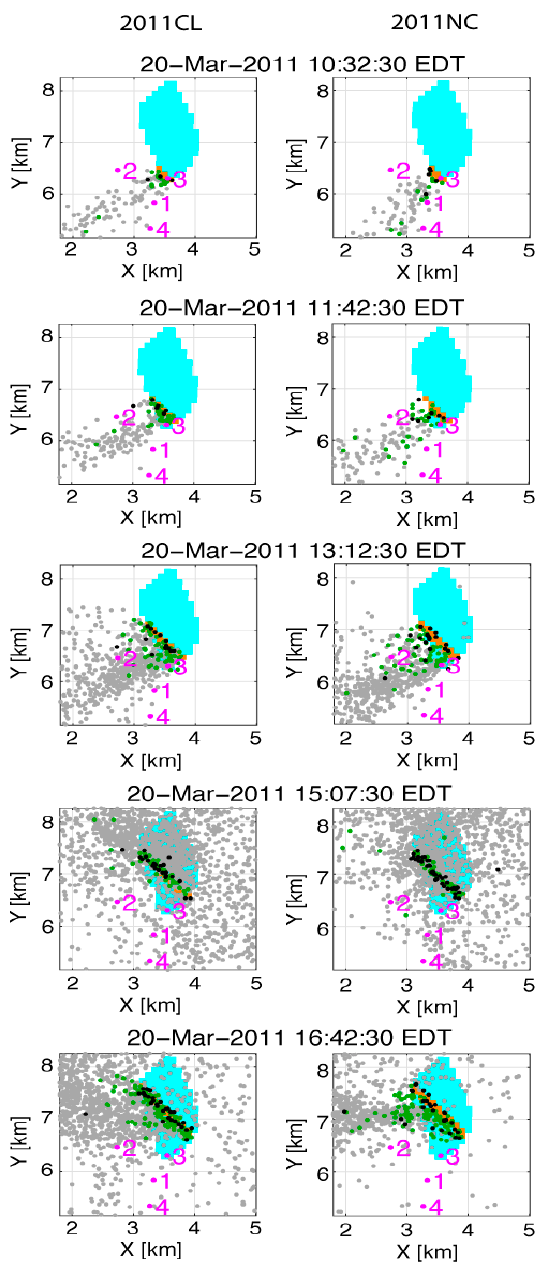
Figure 6. As in the right panels of Figure 2, but with the 2011 no-canopy simulation (2011NC) included for